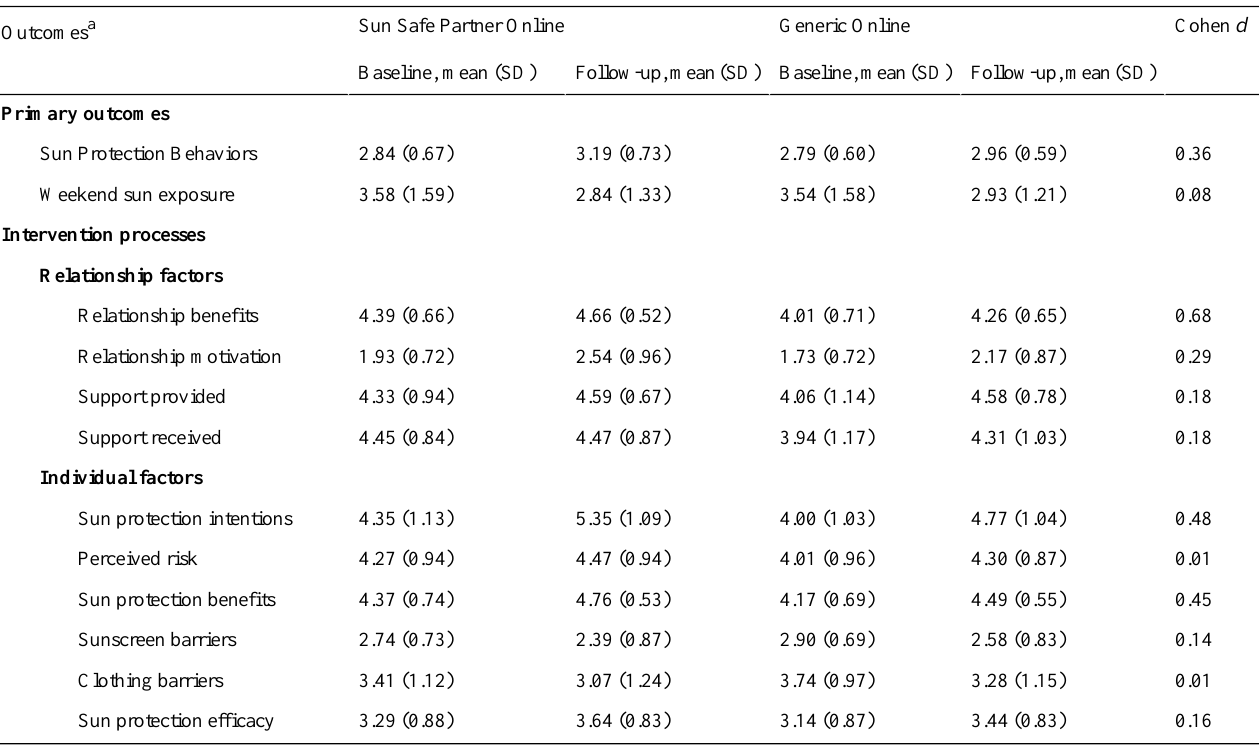
Table 5. Comparisons of the Sun Safe Partners Online with the Generic Online intervention on outcomes and relationship and individual